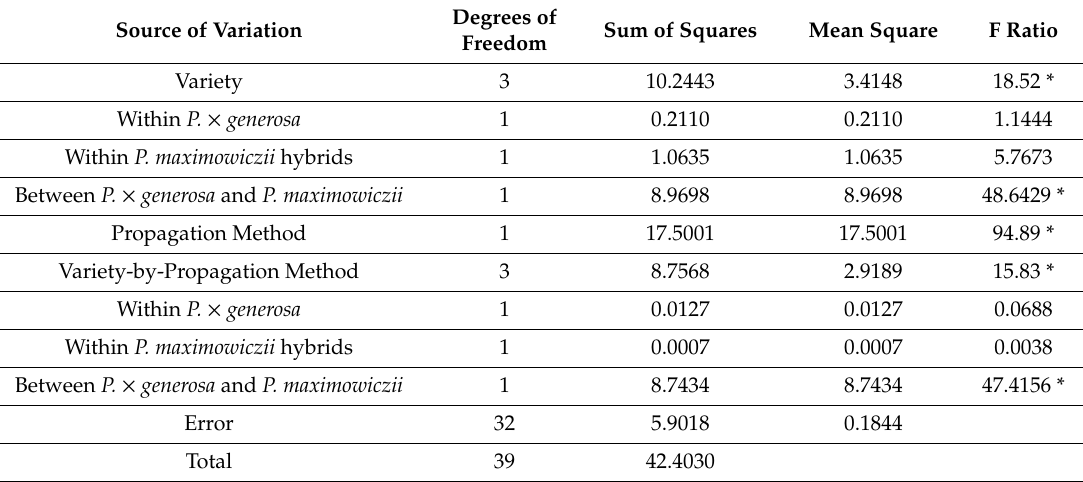
Table 5. Analysis of variance of the yield of macro-cutting yield.